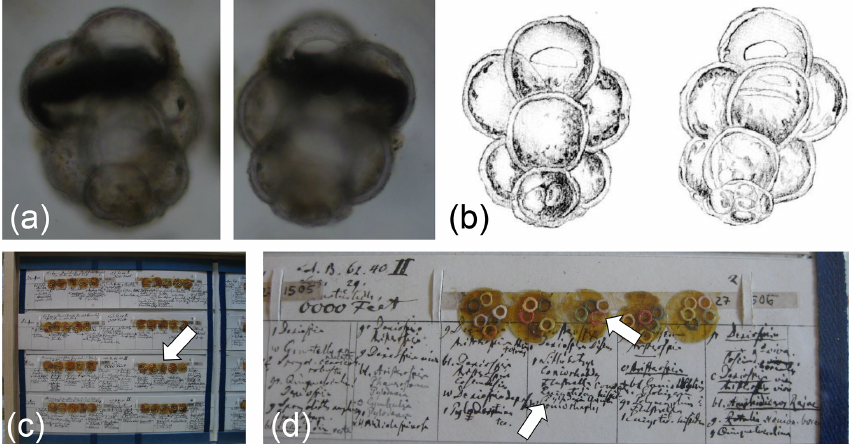
Figure 4. Lectotype of Globigerinita uvula (Ehrenberg, 1862), representing the specimen figured by Ehrenberg (1873) and labelled in his handwriting as Pylodexia uvula . Light microscope image of the lectotype specimen (a) imaged from both sides of the mica mount and compared with (b) the drawing in Ehrenberg (1873). The specimen, about 0.1mm in length, is located in the Ehrenberg Collection at the Museum für Naturkunde in Berlin on Tray 27-15B (c) on mica set 27 1506 (d) , with the lectotype located on mica 3 within the red ring (white arrow) and labelled below (white